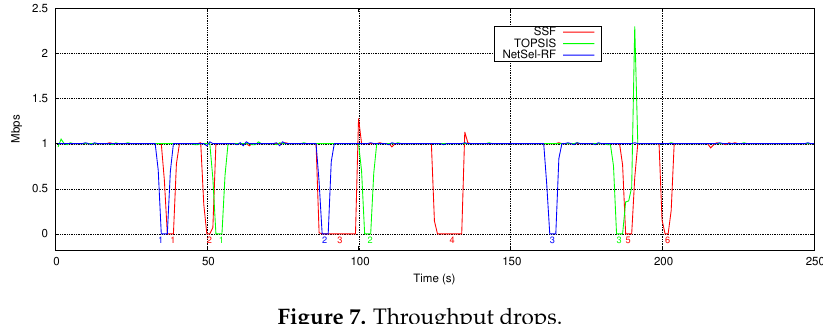
Figure 7. Throughput drops.